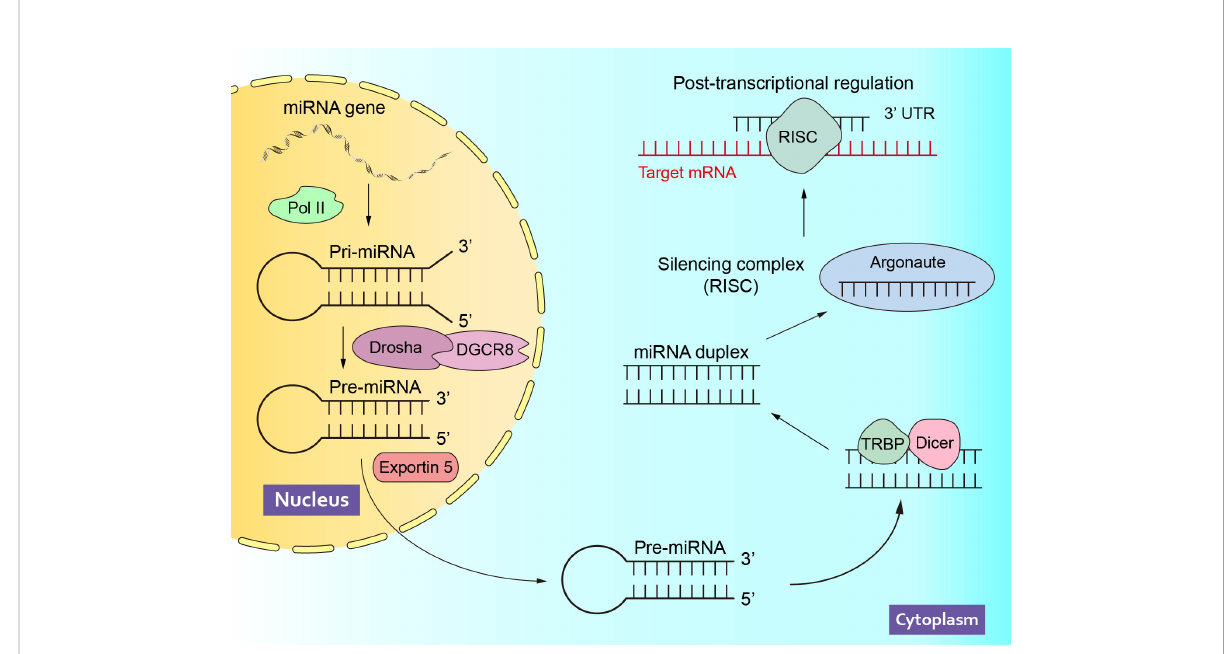
FIGURE 1 The Biogenesis and Function of miRNAs. Pol II, polymerase II; pri-miRNA, primary miRNAs; pre-miRNA, precursor miRNA; RISC, RNA-induced silencing complex; mRNA, messenger RNA; 3 ’ UTR, 3 ’ -untranslated